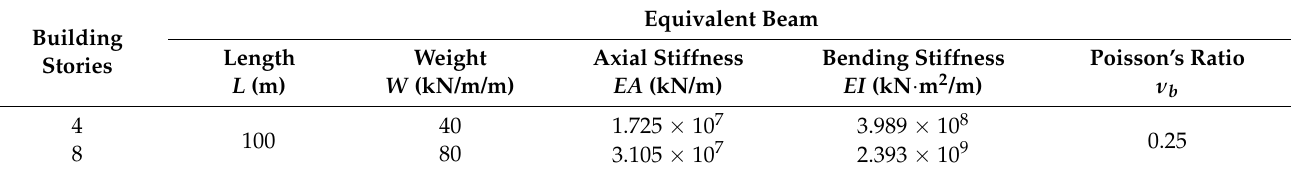
Table 1. Parameters of equivalent beam